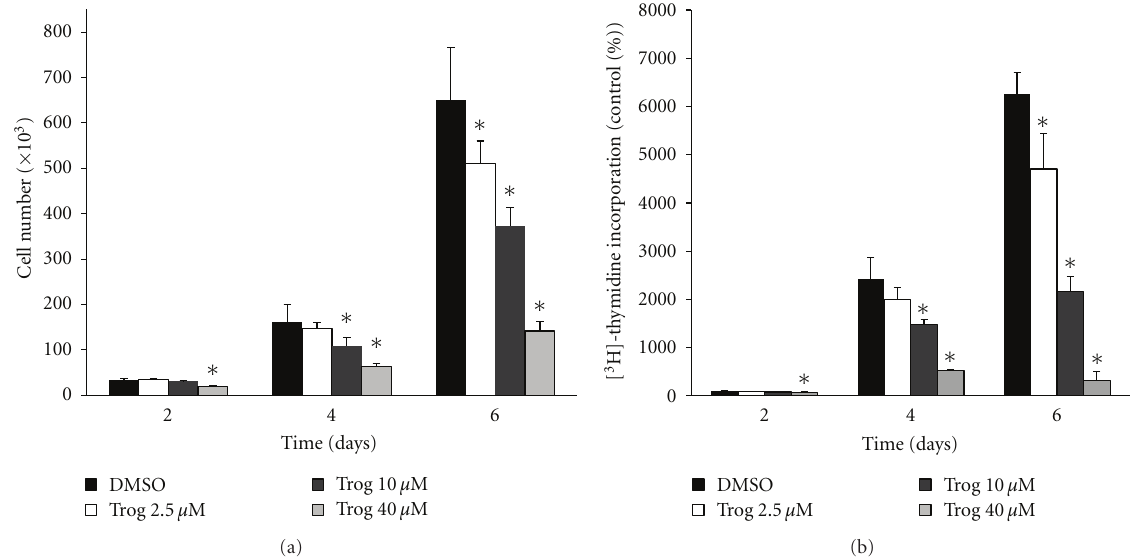
Figure 1: Troglitazone inhibits proliferation of PC-3 human prostate cancer cells. (a) PC-3 cells were plated in 6-well plates at 10,000 cells/ well and treated for up to six days with DMSO vehicle or troglitazone (2.5–40 μ M). Following treatment, the cells in each well were detached using trypsin-EDTA and counted using a Coulter Counter. (b) PC-3 cells were plated in 6 well plates at 10,000 cells/well and treated for up to six days with DMSO vehicle or troglitazone (2.5–40 μ M). Following treatment, the cells were pulsed with [ 3 H]-thymidine for 1.5 hours. The level of [ 3 H]-thymidine incorporation was then measured using a scintillation counter. In both panels, each bar represents the mean ± SD for three wells. ∗ P < 0 . 05 compared to DMSO vehicle at each time point. A representative experiment is shown.